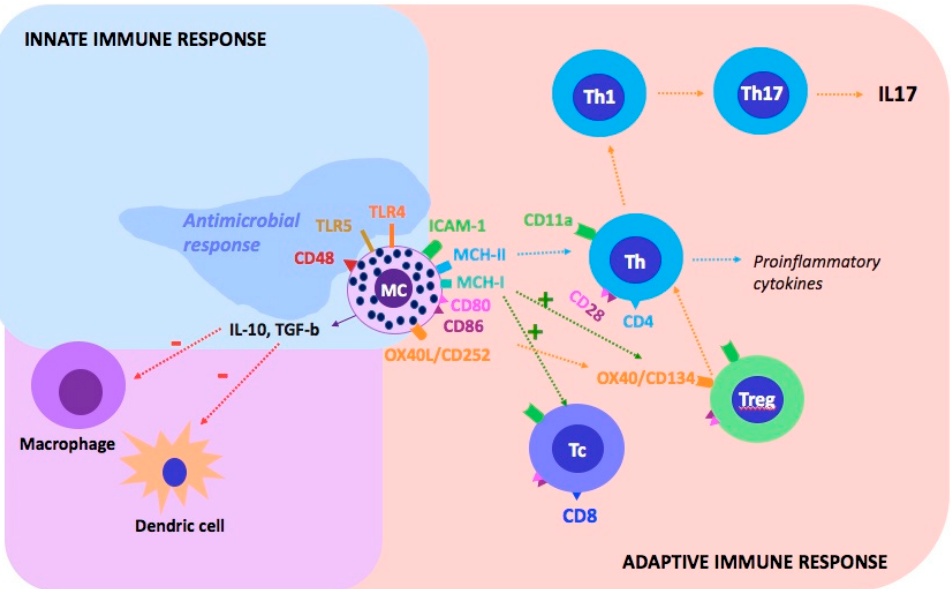
Figure 1. Mast cells and their communication with other cells of the immune system via the surface molecules. MCs participate in the innate and adaptive immune system response. The immunophe- notype of MCs is not homogenous: it may vary depending on the current activity or location. MCs contact T cells indirectly via dendritic cells or directly via adhesion molecules: ICAM-1-ligand for T cell CD11a; MHC-II molecules (activation of CD4 + T cell) and MHC-I (activation of CD8 + T cell and Treg proliferation); CD80 and CD86 costimulatory molecules-ligands for CD28 T cells; OX40L (CD252) for OX40 (CD143) to Treg (redirection of the Treg immunophenotype into Th17; suppres- sion degranulation MCs). TLRs, which bind numerous bacterial peptides, play a key role in the MCs as innate immune cells. The following combinations activate the degranulation of MCs: TLR-4 re- ceptor binds bacterial lipopolysaccharides; TLR-5 to flagellin (a protein that builds the bacterial fla- gellum), the CD48-FimH adhesin present in Escherichia coli, and involved in the response to Strep- tococcus aureus and Mycobacterium tuberculosis. MCs, as inhibitors of the inflammatory process, show activity by secreting IL-10 and TGF- β , which reduce the activity of macrophages and dendritic cells. Tc (cytotoxic T lymphocyte; CD8+), Treg (regulatory T lymphocyte), Th (helper T lymphocyte, CD4 +), MC (mast cell) [33,36].